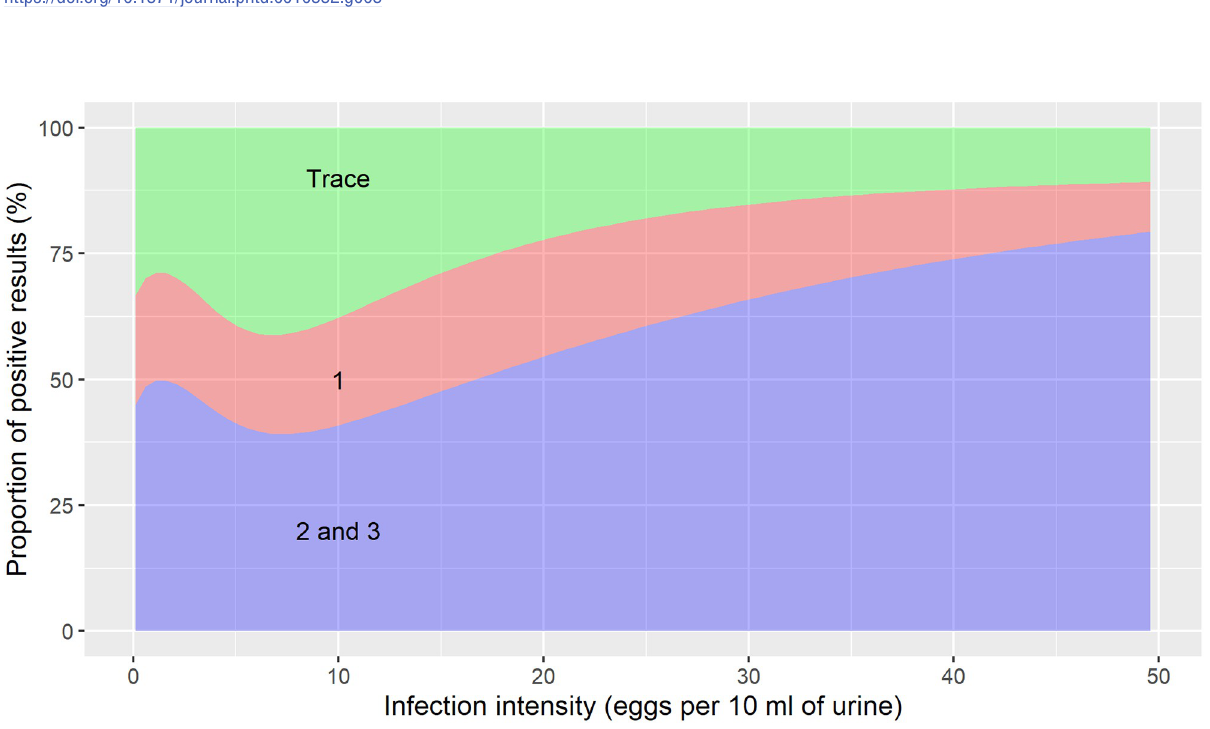
Fig 4. Proportion of semi-quantitative results of reagent strip for microhematuria in relation to S. haematobium infection intensity. The 2+ and 3 + readings were grouped together.